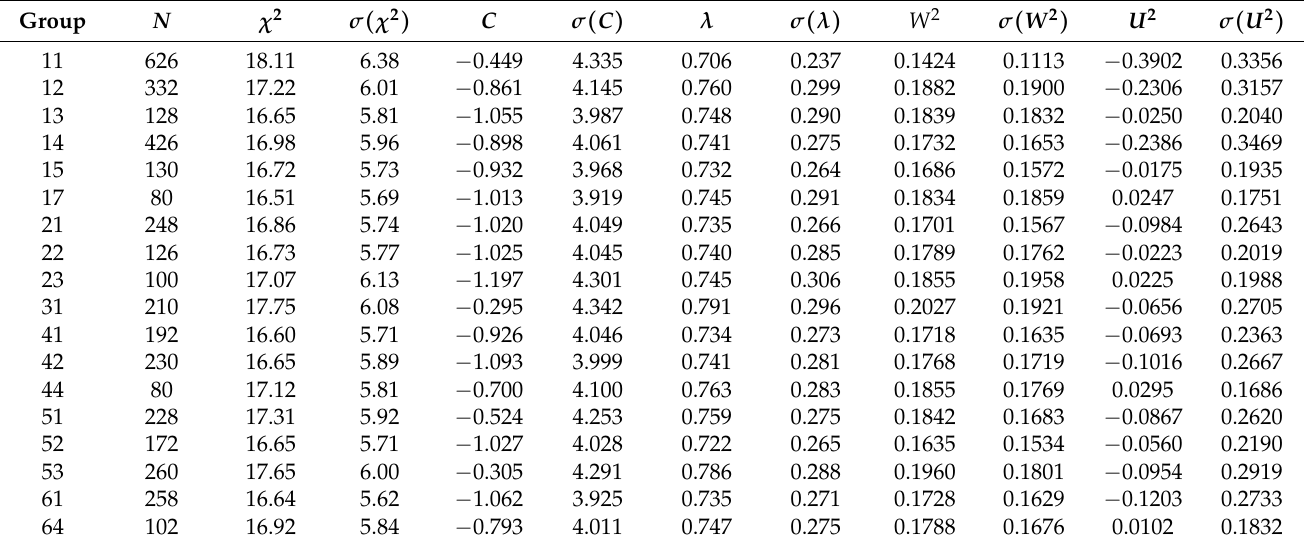
Table 9. Result of the numerical simulations—mean values of η angle statistical tests with standard deviations—part 1.